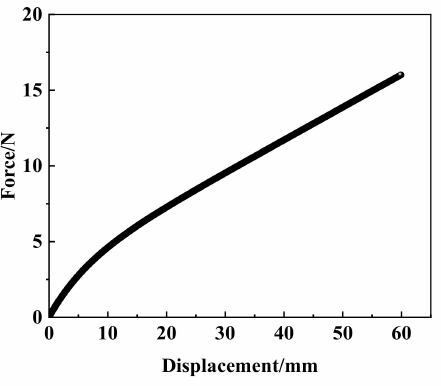
Figure 4. The experimental force-displacement curve of the uniaxial tensile test.